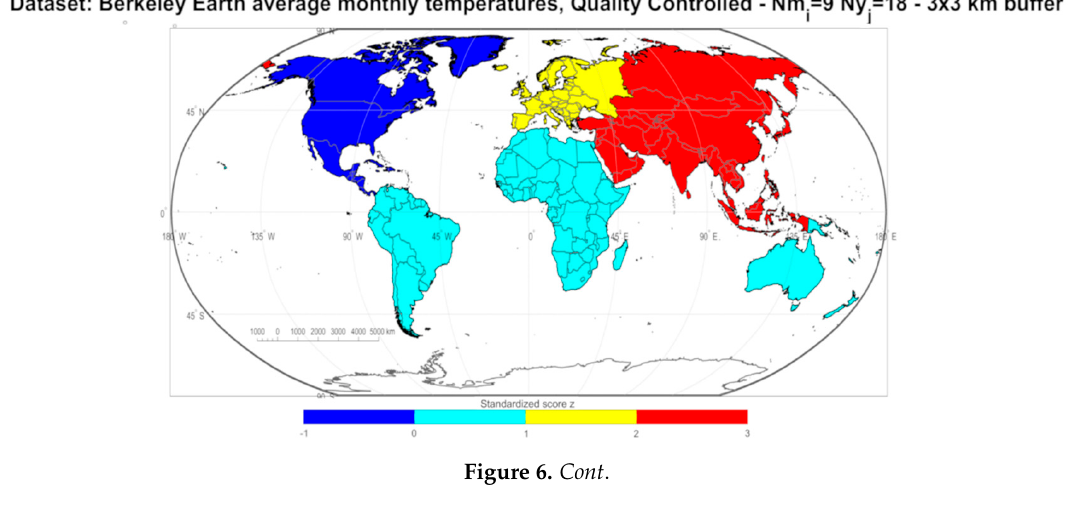
Figure 6. Spatial distribution of statistic indicators of temperature and nightlights trend with a 3 x 3 428 km buffer approximately. Main panel: standardized z values (Equation (16)) at the continental scale 429 ( a – i ) probability of occurrence w of classes of significance from 1 (++) to 4 (--), where CI: concordance 430 index (Equation (13)). E [CI]: expected mean of CI (Equation (14)). σ [CI]: standard deviation of CI 431 (Equation (15)). w T : yellow bars, w L : blue bars. 432